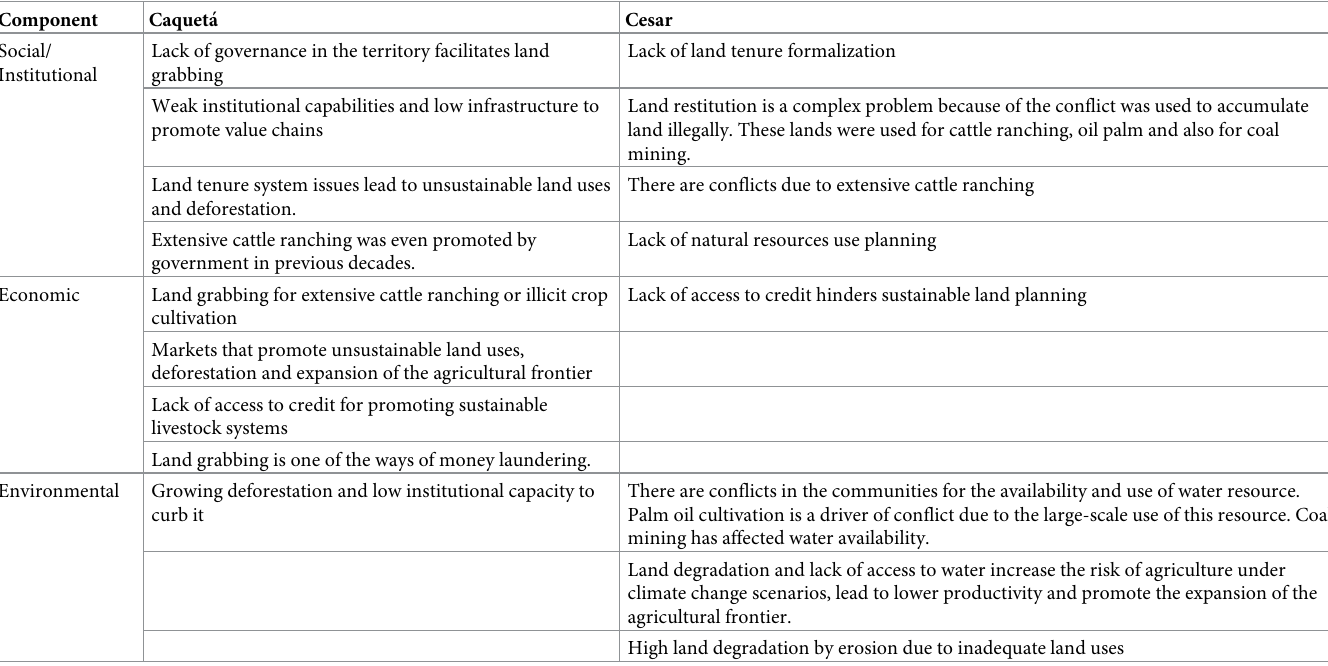
Table 1. Key entry points on land use dynamics in Caqueta´ and